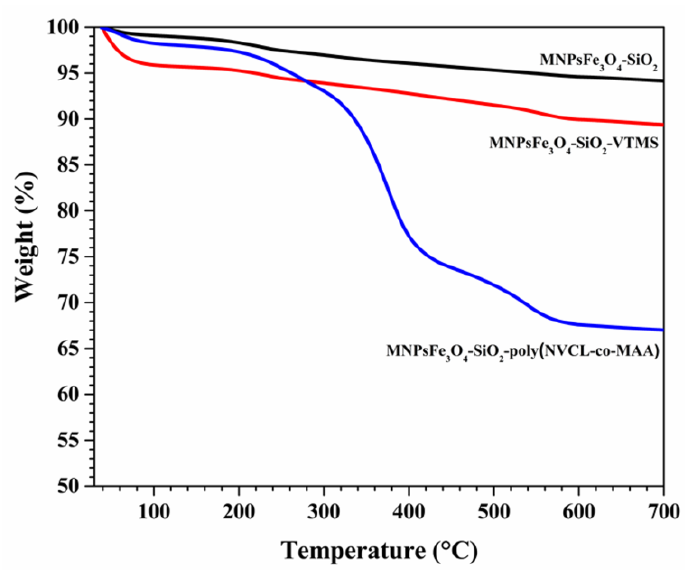
Figure 4. TGA curves of MNPsFe 3 O 4 -SiO 2 , MNPsFe 3 O 4 -SiO 2 -VTMS, and MNPsFe 3 O 4 -SiO 2 -poly (NVCL-co-MAA) nanocomposites.